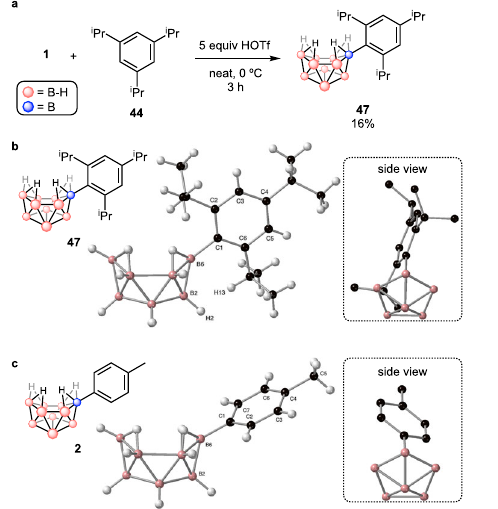
Fig. 5 | Comparison of solid-state structures of 47 and 2. a Synthesis of 47 . b Solid-statestructureof 47 .Selectedbonddistance(Å)andtorsionalangle(°):B6- C1 1.5818(15); B2-B6-C1-C2 157.27(11). c Solid-state structure of 2 (ref. 36 ) for com- parison.Selectedbonddistance(Å)andtorsionalangle(°):B6-C11.555(3);B2-B6-C1- C7 116.6(2). The insets are the side views projecting from the boron cages to the aryl